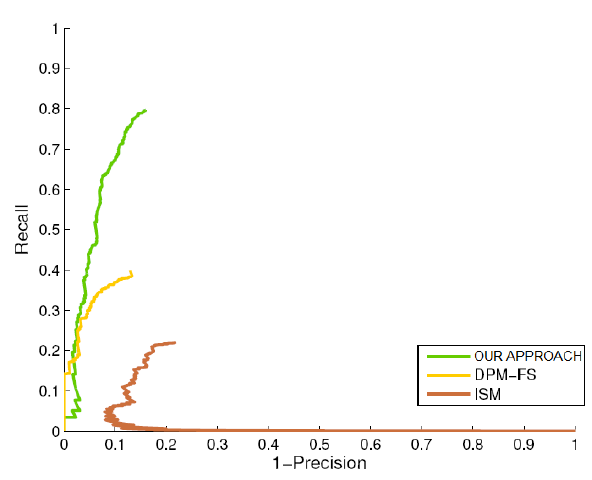
Figure 11. RPC for the Highway sequence. Detection characteristics of the Highway Sequence for different methods sorted by the F-measure. Table 5. The Recall and Precision Comparison Methods